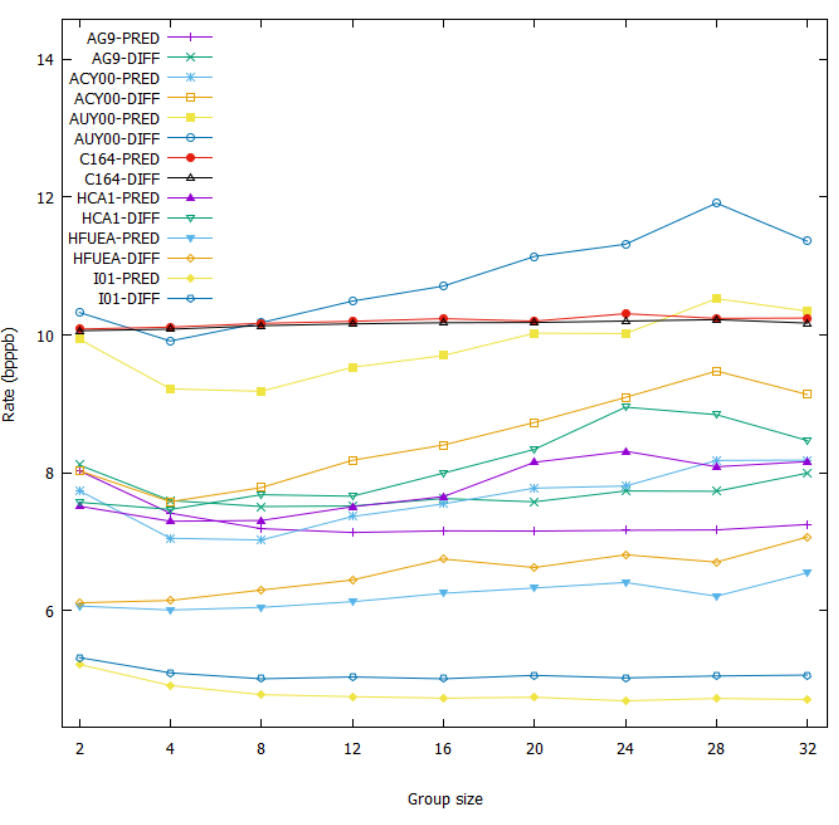
Figure 13. A rate (bpppb) comparison of different group sizes. Table 7. A rate (bpppb) comparison of different group sizes using the predictive and the differential methods. The optimal values are highlighted in